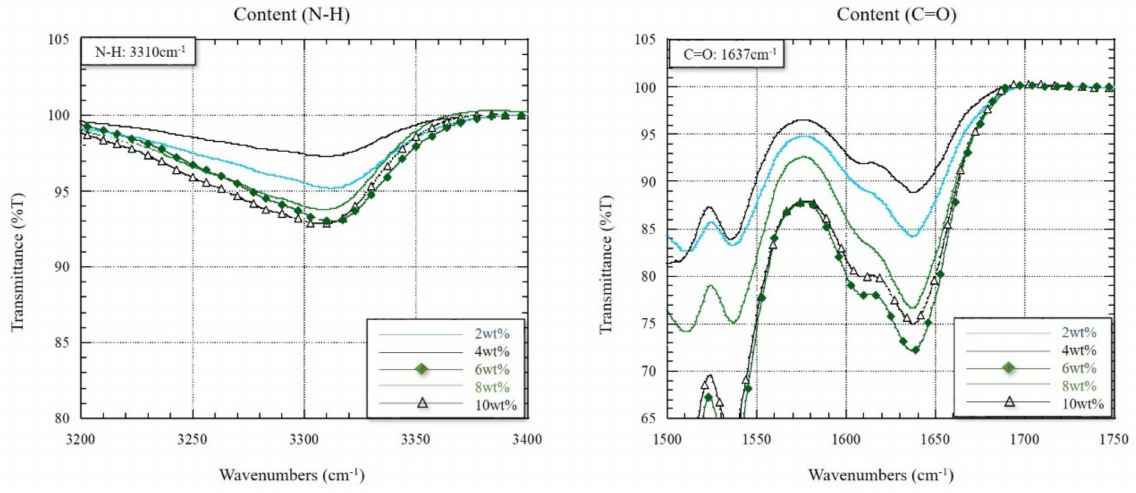
Figure 5. FT-IR analysis of ZnCl 2 surface-treated aramid fabrics in various concentrations.